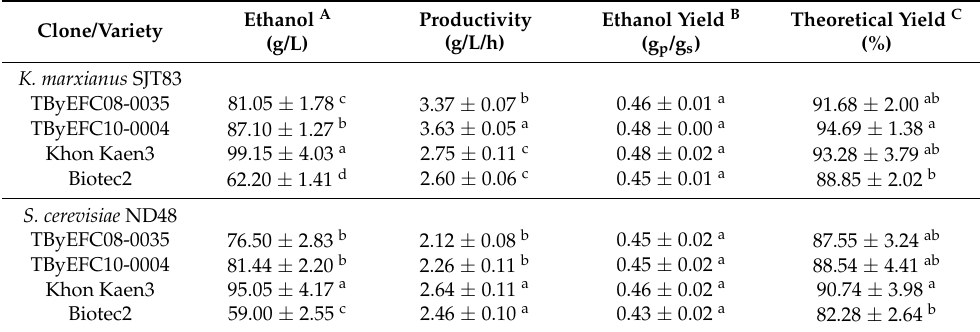
Table 4. Ethanol production by K. marxianus SJT83 and S. cerevisiae ND48 from juice of energy cane clones and control